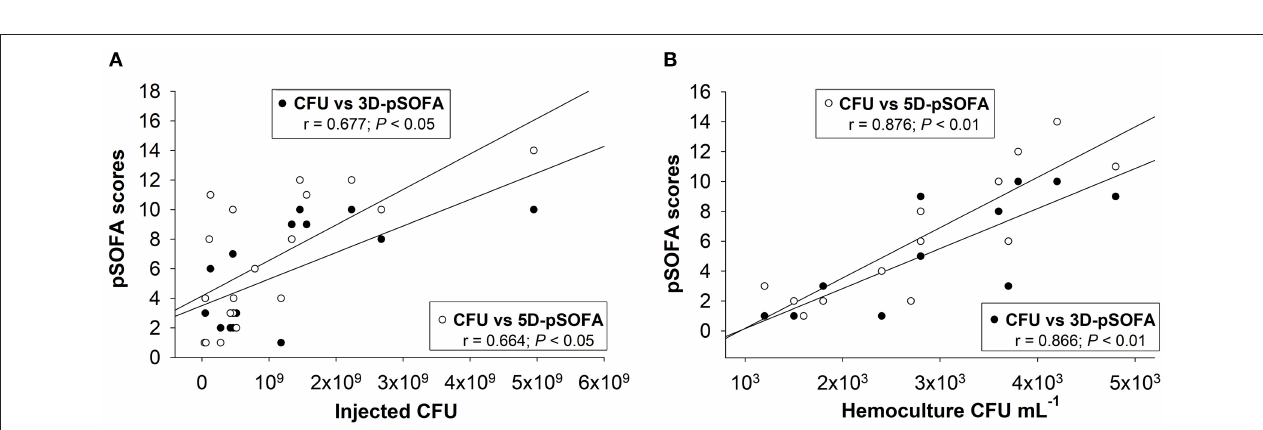
FIGURE 7 | Correlation between the concentration of injected microorganism in feces and the pSOFA score values (A) . Correlation between the microbial concentration in the hemoculture and the pSOFA score values (B) .